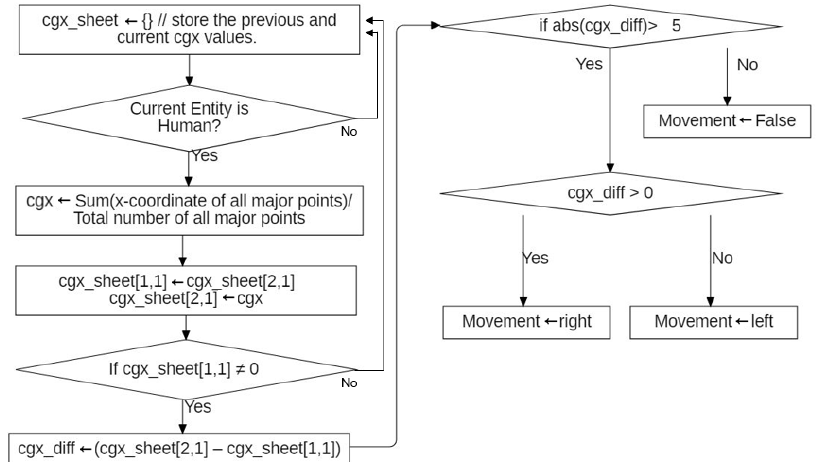
Figure 1. Center gravity method. Array cgx_sheet is defined to store the previous and current cgx values. Center gravity point, cgx is defined as an average value of all x-coordinate values at a certain frame. The integer variable cgx_diff is defined to calculate differences between adjacent two